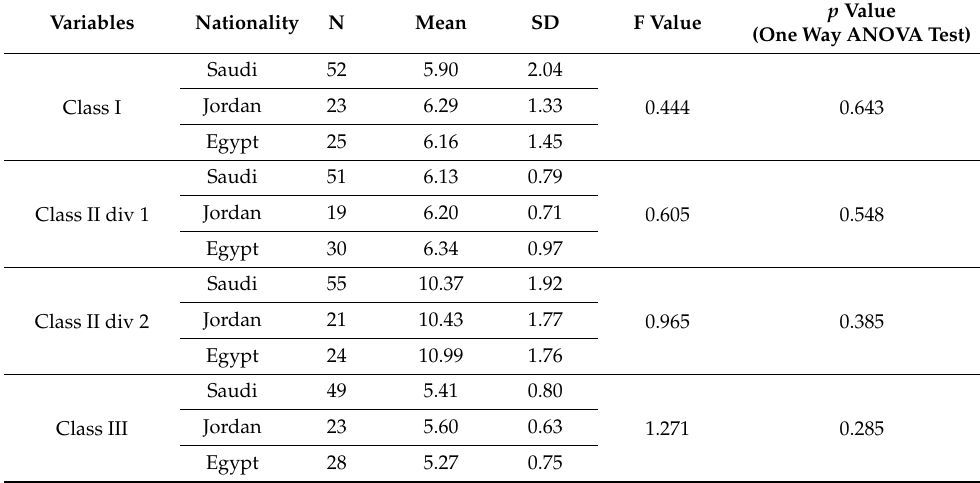
Table 3. Racial-wise comparison of CA.